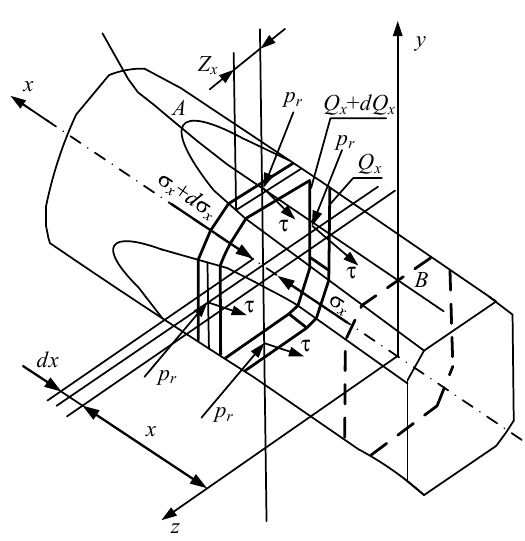
Figure 3. Diagram of forces acting on the elementary volume in the backward slip zone.